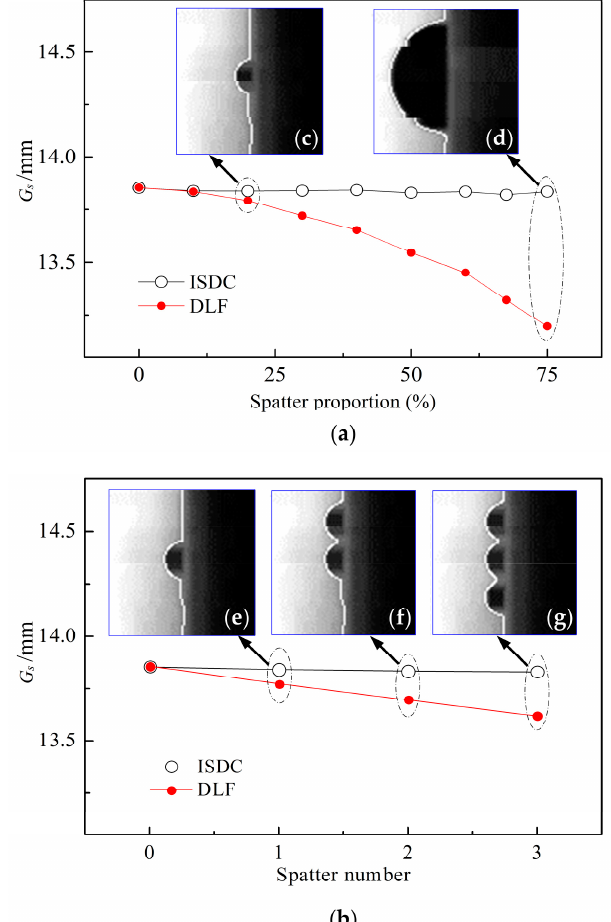
Figure 7. Effect of simulated spatter size proportion and number on sampling value G s of groove width: ( a ) spatter size proportion; ( b ) spatter number; ( c ) simulated spatter of size proportion 20%; ( d ) simulated spatter of size proportion 75%; ( e ) one simulated spatter in ROI window image; ( f ) two simulated spatters in ROI window image; ( g ) three simulated spatters in ROI window